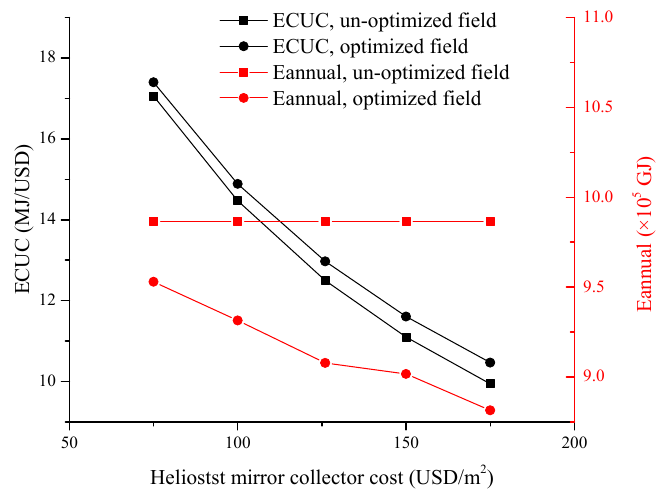
Figure 8. Effect of heliostat mirror collector cost on energy collected of unit cost and annual energy collected.